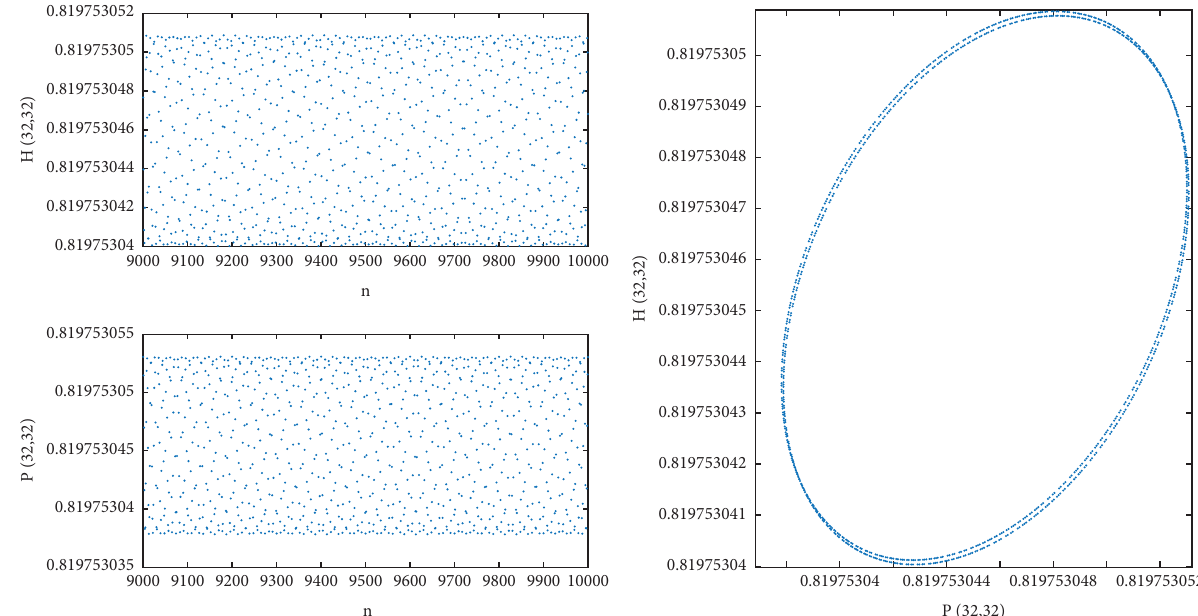
Figure 23: R � 2 ,k � 1, c � 0 . 8, σ ∗ � 0 . 278655, σ � σ ∗ , ( d which is consistent with the case of Corollary 3(7), a Neimark-Sacker-Flip bifurcation occurs, the number of parasites and hosts can show periodic doubling and periodic oscillation